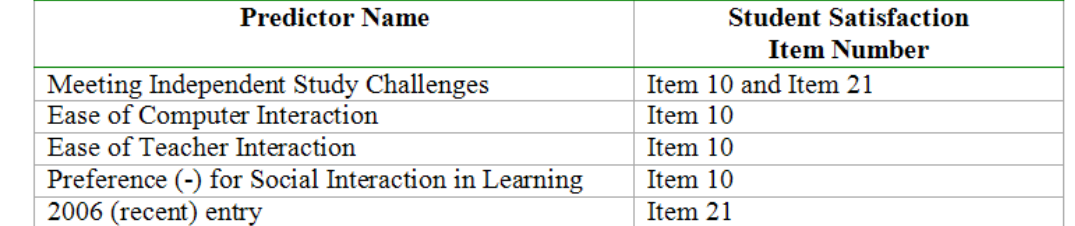
Table 5. Significant predictors of Learning